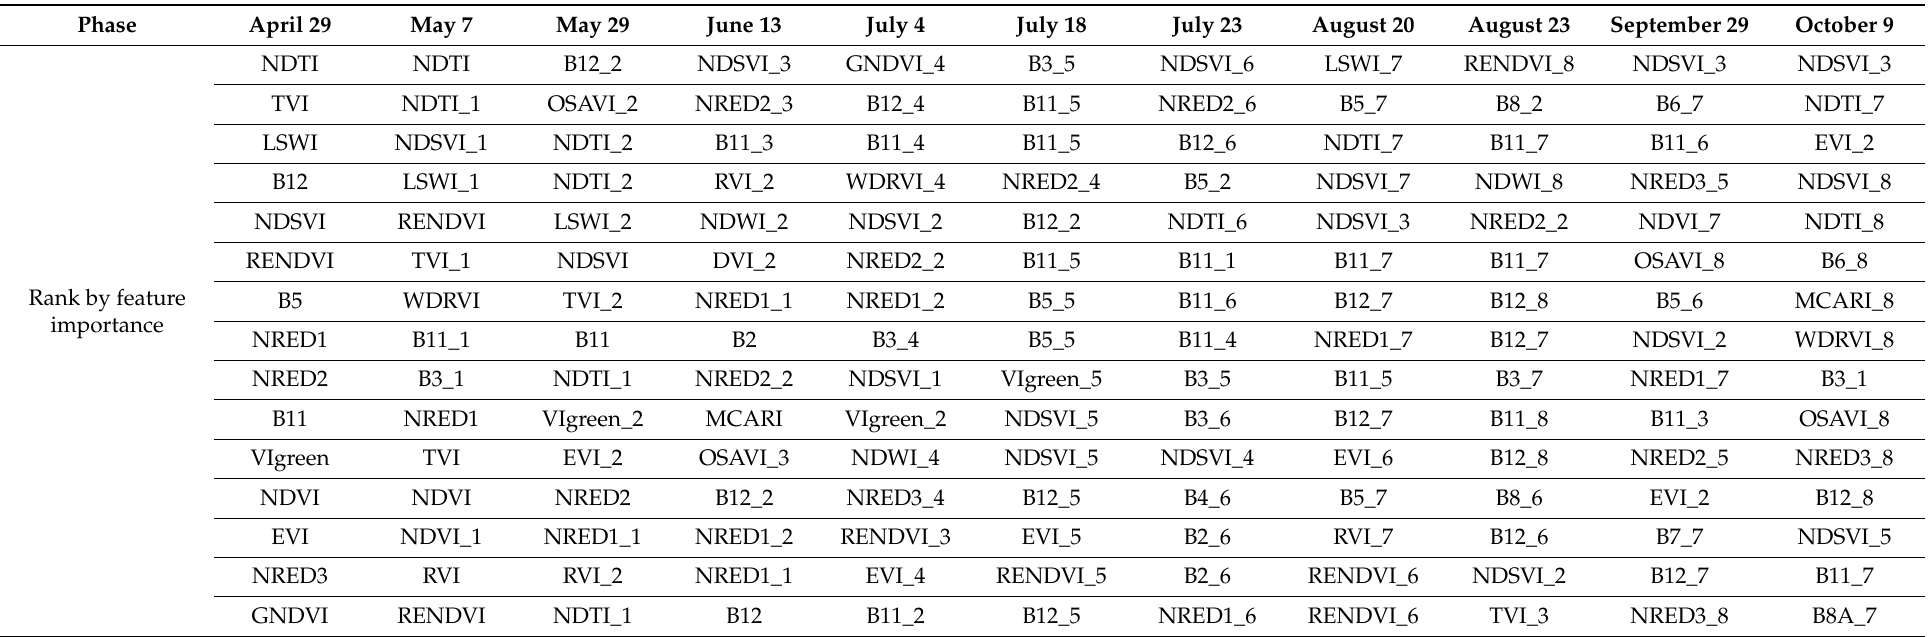
Table A3. Optimal feature sets at different periods in Region